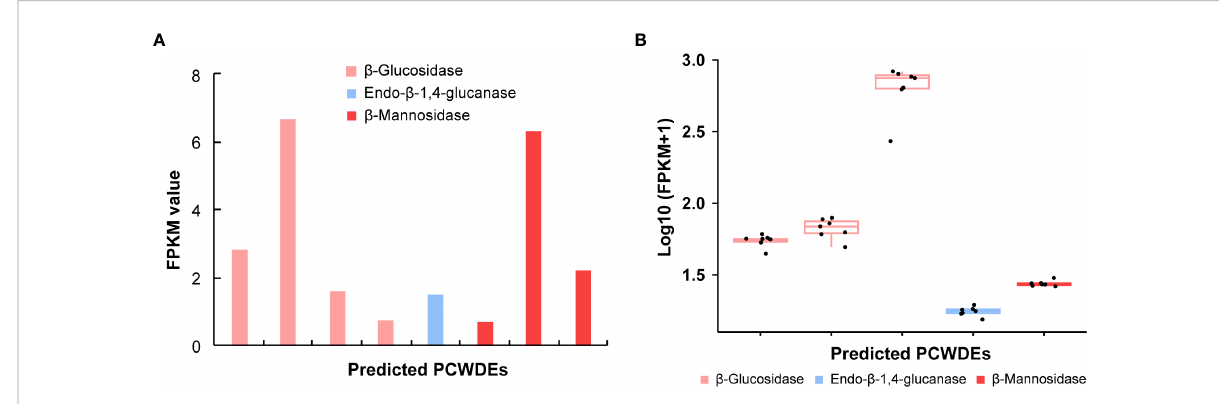
FIGURE 4 The expression patterns of genes encoding plant cell wall-degrading enzymes (PCWDEs) in different samples of Pseudoregma bambucicola . (A) The expression pattern of different PCWDEs identi fi ed from salivary glands. The bars from left to right in the histogram represent b -glucosidase 1, b -glucosidase 4, b -glucosidase 5, b -glucosidase 6, endo- b -1,4-glucanase 1, beta-mannosidase 2, beta-mannosidase 3 and beta-mannosidase 1, respectively (see Table S6 for details). (B) The expression pattern of PCWDEs across different morphs or developmental stages. The boxplots from left to right represent b -glucosidase 1, b -glucosidase 2, b -glucosidase 3, endo- b -1,4-glucanase 1 and beta- mannosidase 1, respectively. The black dots in each box in fi gure B represent Pseudoregma bambucicola of different morphs or developmental stages, including newborn 1st instar soldiers, older 1st instar soldiers, newborn 1st instar normal nymphs, older 1st instar normal nymphs, middle-stage normal nymphs, soldier producing adults and normal nymph producing